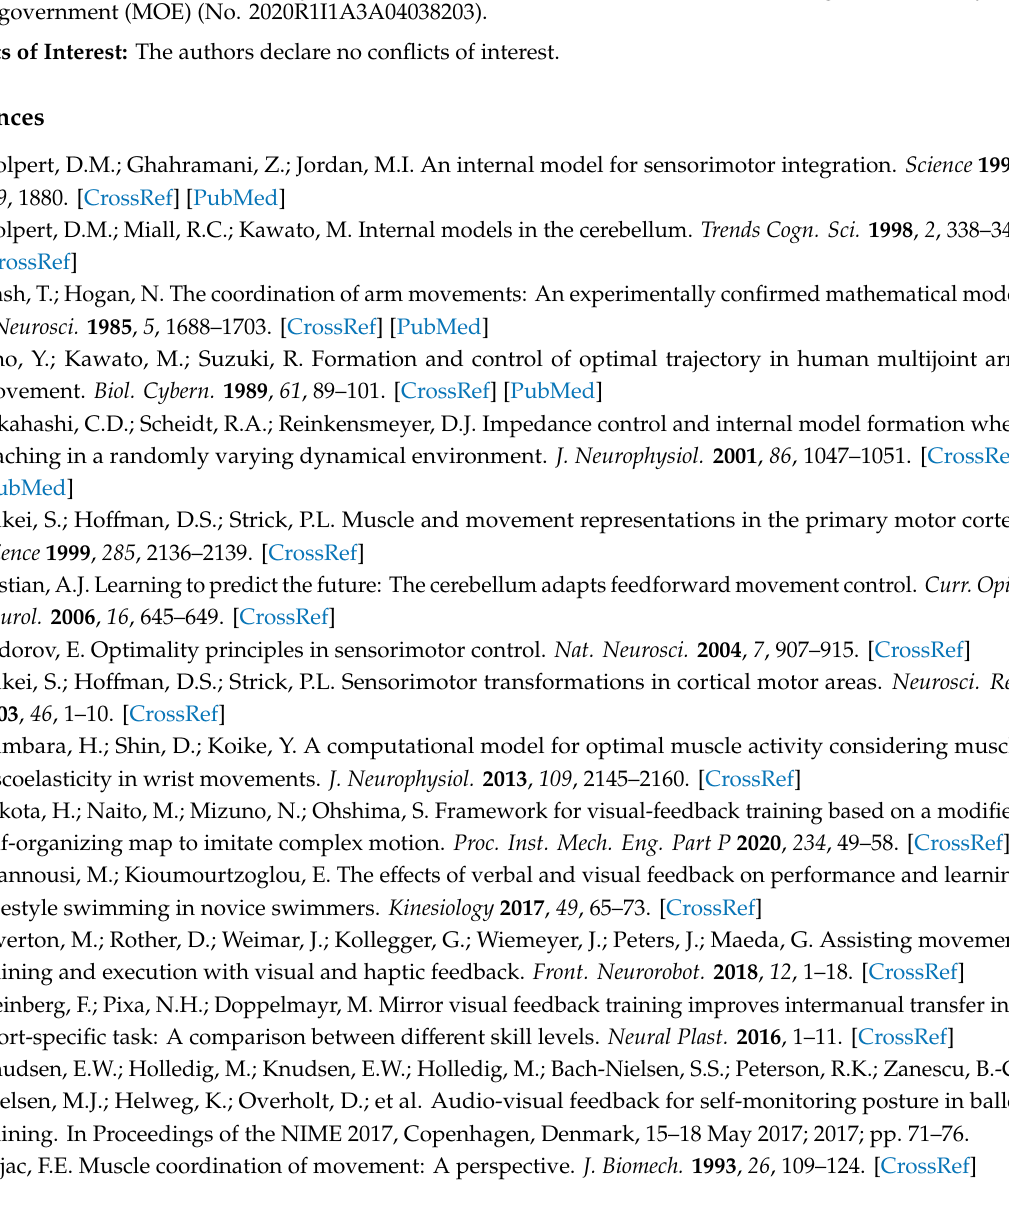
Table S1: a summary of statistical analysis of IPV2 for the circular tracking movement, Table S2: a summary of statistical analysis of IPT2 for the circular tracking movement, Table S3: a summary of statistical analysis of TD2 for the circular tracking